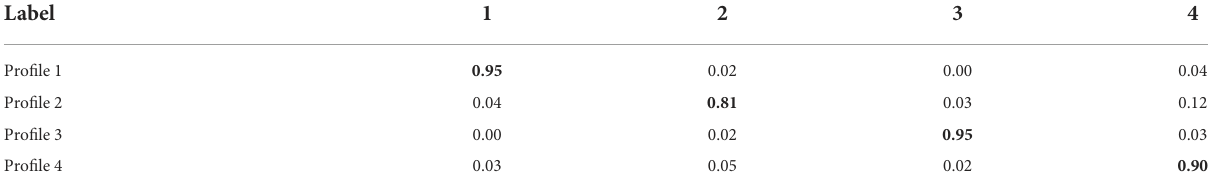
TABLE 3 Average posterior probabilities for the four-profile